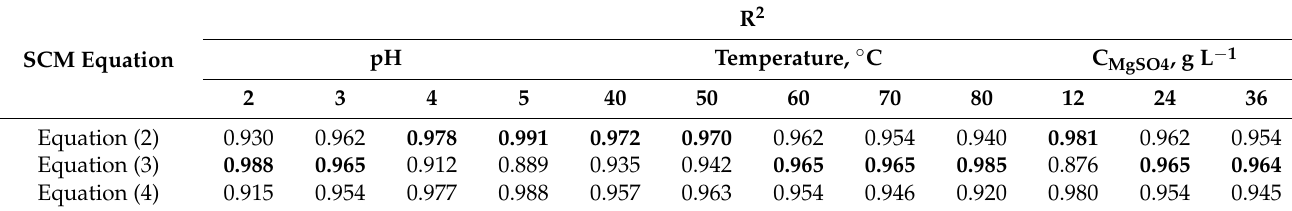
Table 5. Shrinking core model (SCM) equations fitting